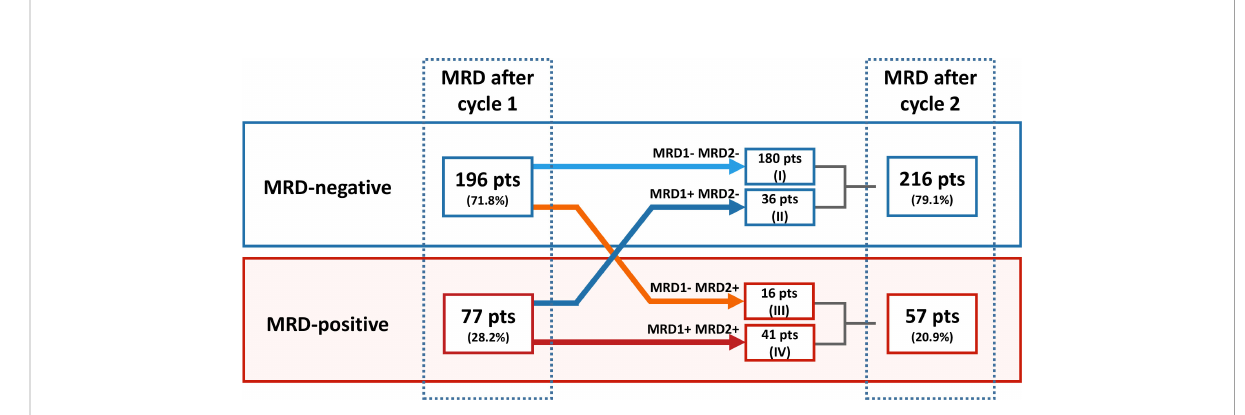
FIGURE 3 Fluctuations of MRD status between measurement after induction chemotherapy cycle I and the time point after chemotherapy cycle II. After one cycle of chemotherapy, 196 patients (71.8%) became MRD-negative and 77 patients were MRD-positive. After two cycles of chemotherapy, 216 patients (79.1%) were MRD-negative of which 180 were already MRD-negative after cycle 1 and 36 converted from MRD-positive to